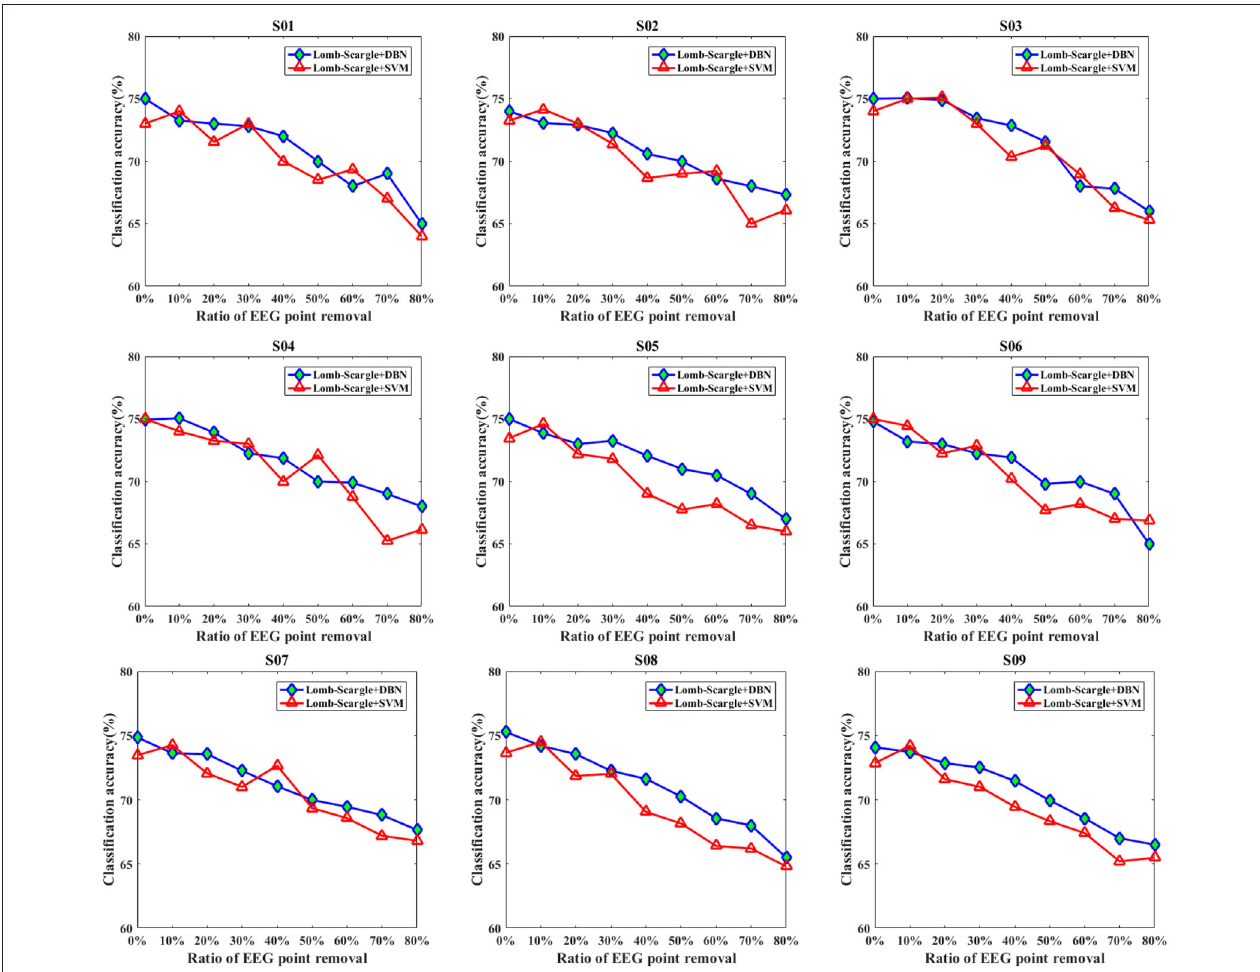
FIGURE 7 | The comparative performances between DBN and SVM classifiers for the intact EEG and incomplete EEG with various ratios of data point removal (from 10 to 80% with a step of 10%), for the nine subjects (from S01 to S09).